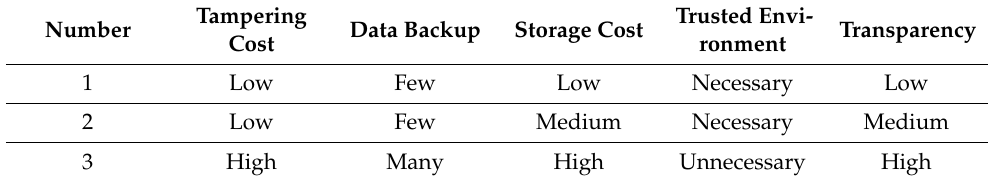
Table 1. Comparison of three different architectures of traceability